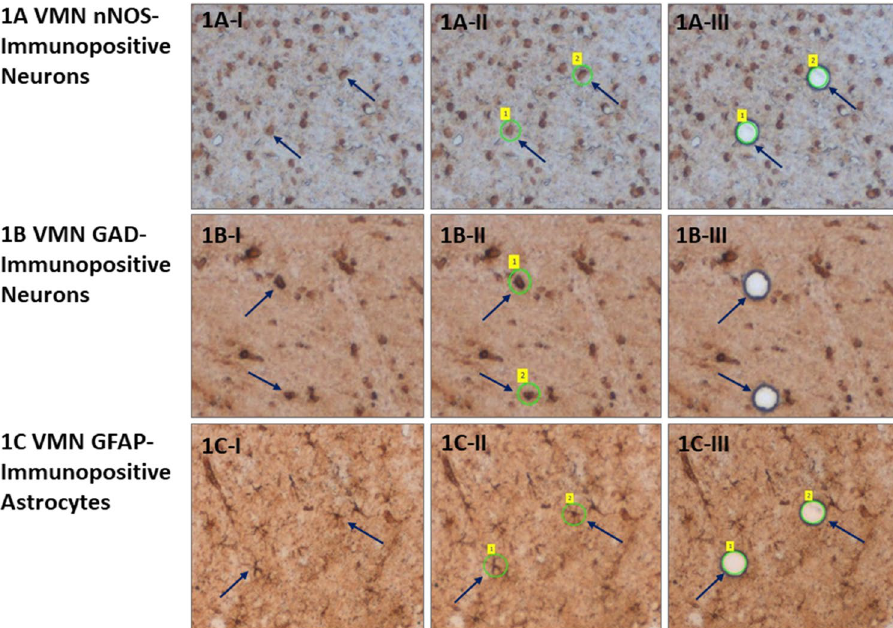
Figure 1. Laser–catapult microdissection of immunolabeled ventromedial hypothalamic nucleus (VMN) astrocytes and metabolic-sensory neurons. Nitric oxide (NO) neurons, and γ-aminobutyric acid (GABA) neurons and. VMN cells were identified in situ for neuronal nitric oxide (nNOS)- ( A ; top row), glutamate decarboxylase 65/67 (GAD)- ( B ; middle row), or glial fibrillary acidic protein (GFAP)- ( C ; bottom row) immunoreactivity (-ir). Representative nNOS- or GAD 65/67 -ir-positive neurons and GFAP-immunolabeled astrocytes are blue arrows. Areas depicted in Figures ( A-I ), ( B-I ), and ( C-I ), were re-photographed after positioning of a continuous laser track (depicted in green) around individual nNOS-ir ( A-II ; blue arrow), GAD-ir ( B-II ; blue arrow), or GFAP-ir ( C-II ; blue arrow) cells and subsequent ejection by laser pulse (Figures A-III , B-III , C-III ). Note that this microdissection technique causes negligible destruction of surrounding tissue and minimal inclusion of adjacent tissue. Scale bars at the bottom right of Figures ( A-III ), ( B-III ), and ( C-III ): 100